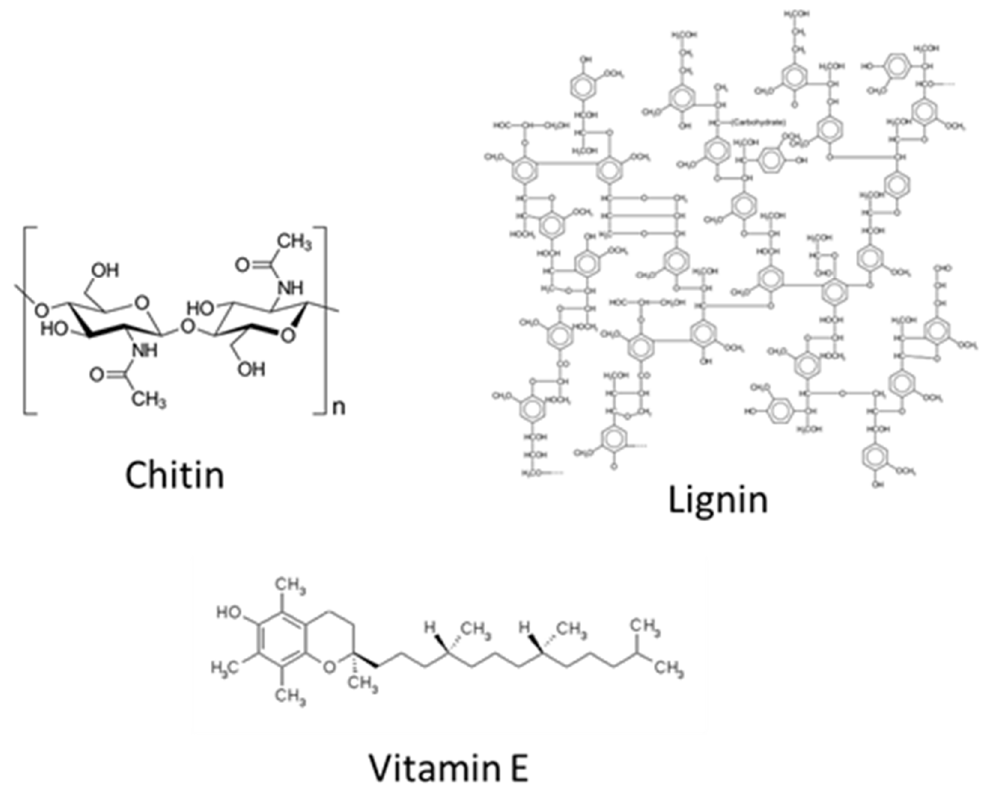
Figure 2. Chemical structure of chitin, lignin and Vitamin E.